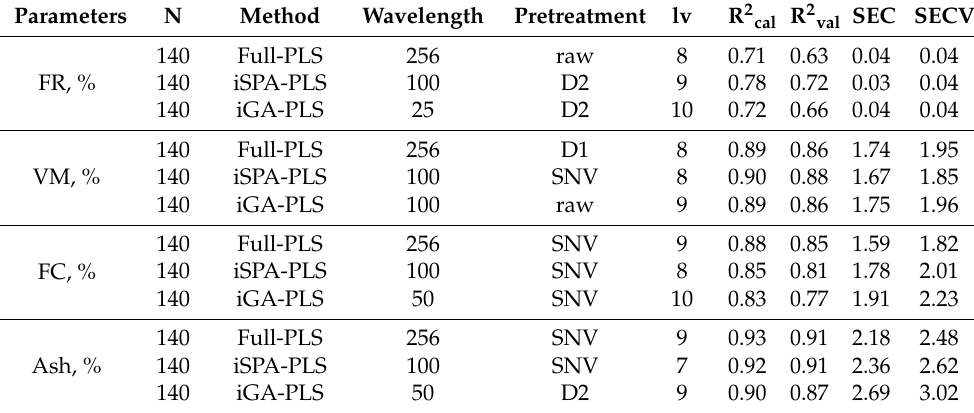
Table 3. The result of optimal wavelength selection conducted with full wavelength, interval successive projections algorithm (iSPA) wavelength, and interval genetic algorithm (iGA) wavelength. PLS: partial least